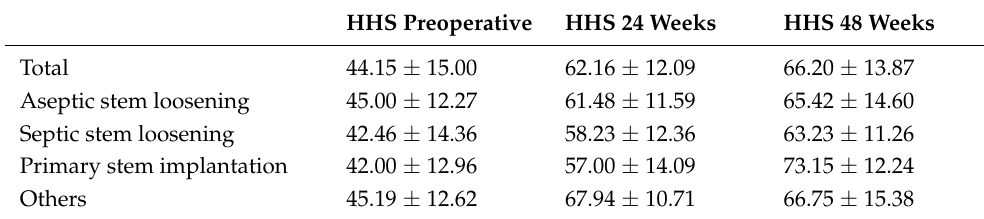
Table 2. Clinical outcome with HHS preoperatively, at 24 weeks and 48